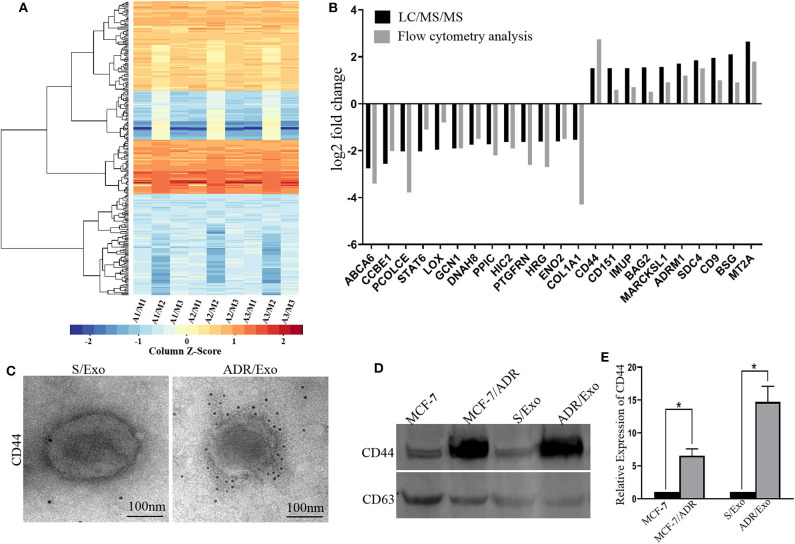
DOX-resistant breast cancer cells spread resistance capacity by transferring resistance-associated proteins, especially CD44, to sensitive cells. (A) The exosomes extracted from MCF-7/ADR cells with three biological replications were labeled as A1, A2, and A3. The exosomes extracted from MCF-7 cells with three biological replications were labeled as M1, M2, and M3. A/M stands for the log2 (fold change) results, which was the average protein signal ratio of the A and M groups. Then we performed the heat map analysis based on the log2 (fold change) results. In the heat map analysis, blue indicates the downregulated proteins, and red indicates the upregulated. (B) We further verified these differently expressed proteins by flow cytometry analysis, which was also consistent with the proteomic analysis. (C) The immunogold staining showed that more immunogold particles were bound to the exosomes, thus? indicating that CD44 was highly stored inside A/Exo. (D,E) Western blot results indicated that the protein level of CD44 was significantly upregulated in A/Exo compared with that in S/Exo (p < 0.05), and the increase level of CD44 in A/Exo (14.76-fold) was much higher than that in MCF-7/ADR cells (6.56-fold). *p < 0.05.